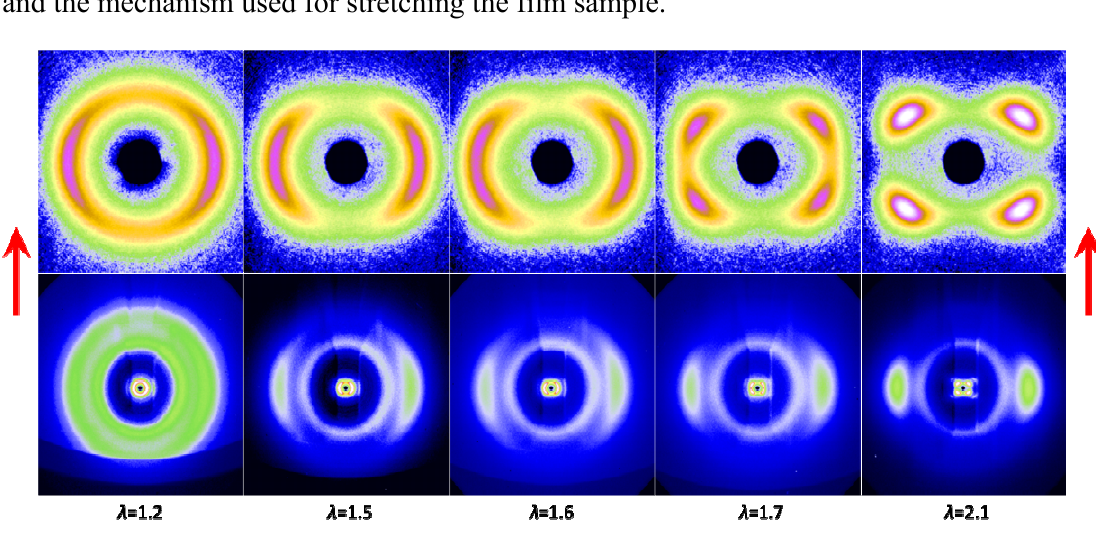
Figure 9. LCE1: Representative SAXS (top row) and WAXS (bottom row) patterns recorded ~ 20 min after the application of different uniaxial strains in the direction of the red arrows. The patterns in the bottom row also show shadows of parts of the sample oven and the mechanism used for stretching the film